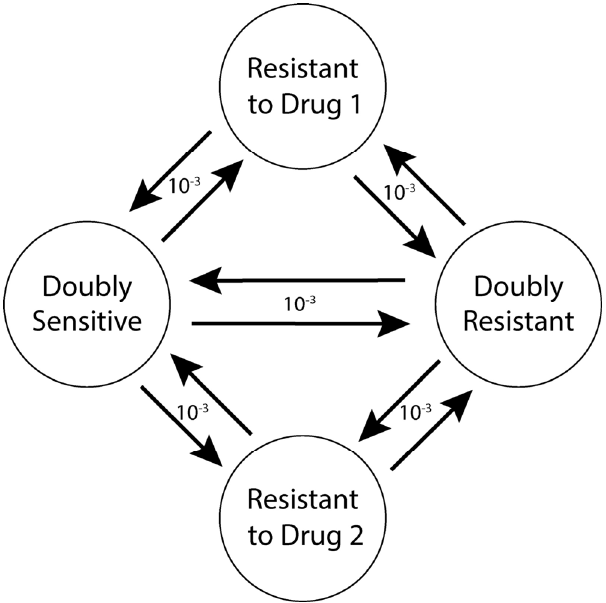
Figure 2. Mutation Schematic. A given cell type can mutate to any other cell type but itself with an equal probability of 10 − 3 per cell division. Doubly sensitive cells can mutate to become doubly re- sistant cells in one step (e.g., due to multiple drug resistance mechanisms [38]) or via an intermediate